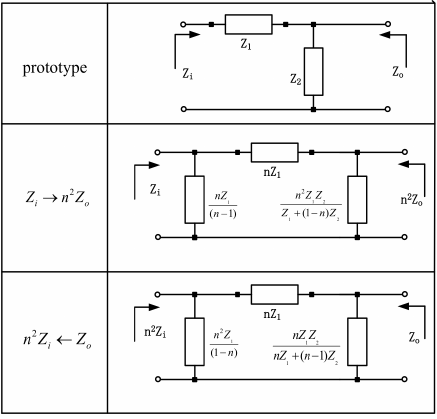
Figure 4. The process of Norton transformation.